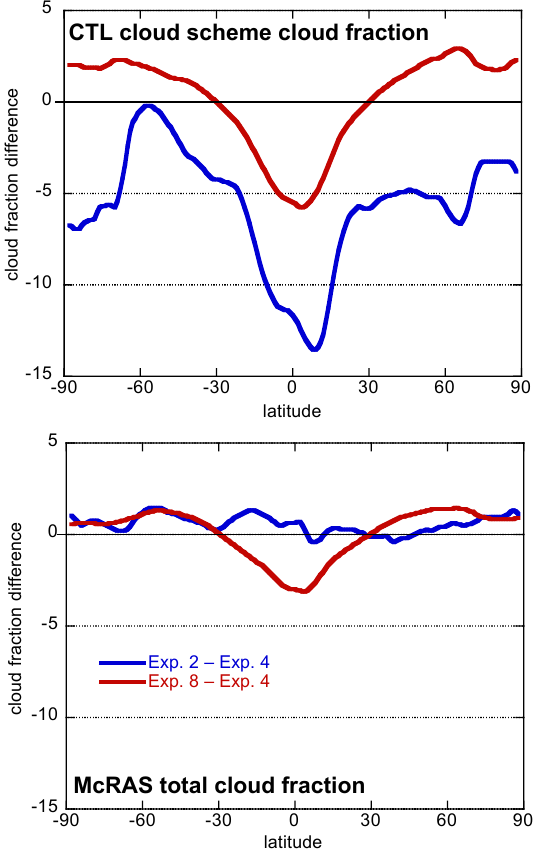
Fig. 8. Zonally-averaged differences of C tot (on a scale 0–100) for Exp. 2–Exp. 4 (blue curves) and Exp. 8–Exp. 4 (red curves). The top panel is for the CTL cloud scheme, while the bottom panel is for McRAS-AC.